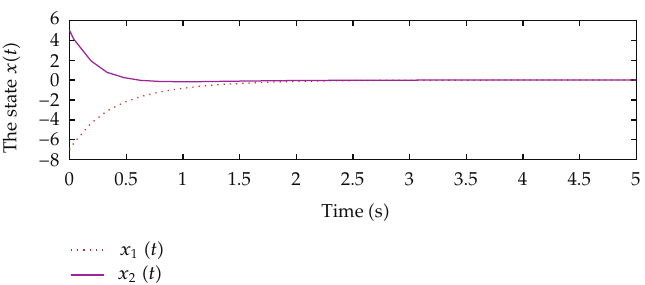
Figure 1: State trajectories x 1 (cid:2) t (cid:3) and x 2 (cid:2) t (cid:3) of LPD time-delay system (cid:2) 2.1 (cid:3) with (cid:2) 4.1 (cid:3) , α 1 (cid:9) α 2 (cid:9) α 3 (cid:9) 1 / 3 by using program dde45lin with